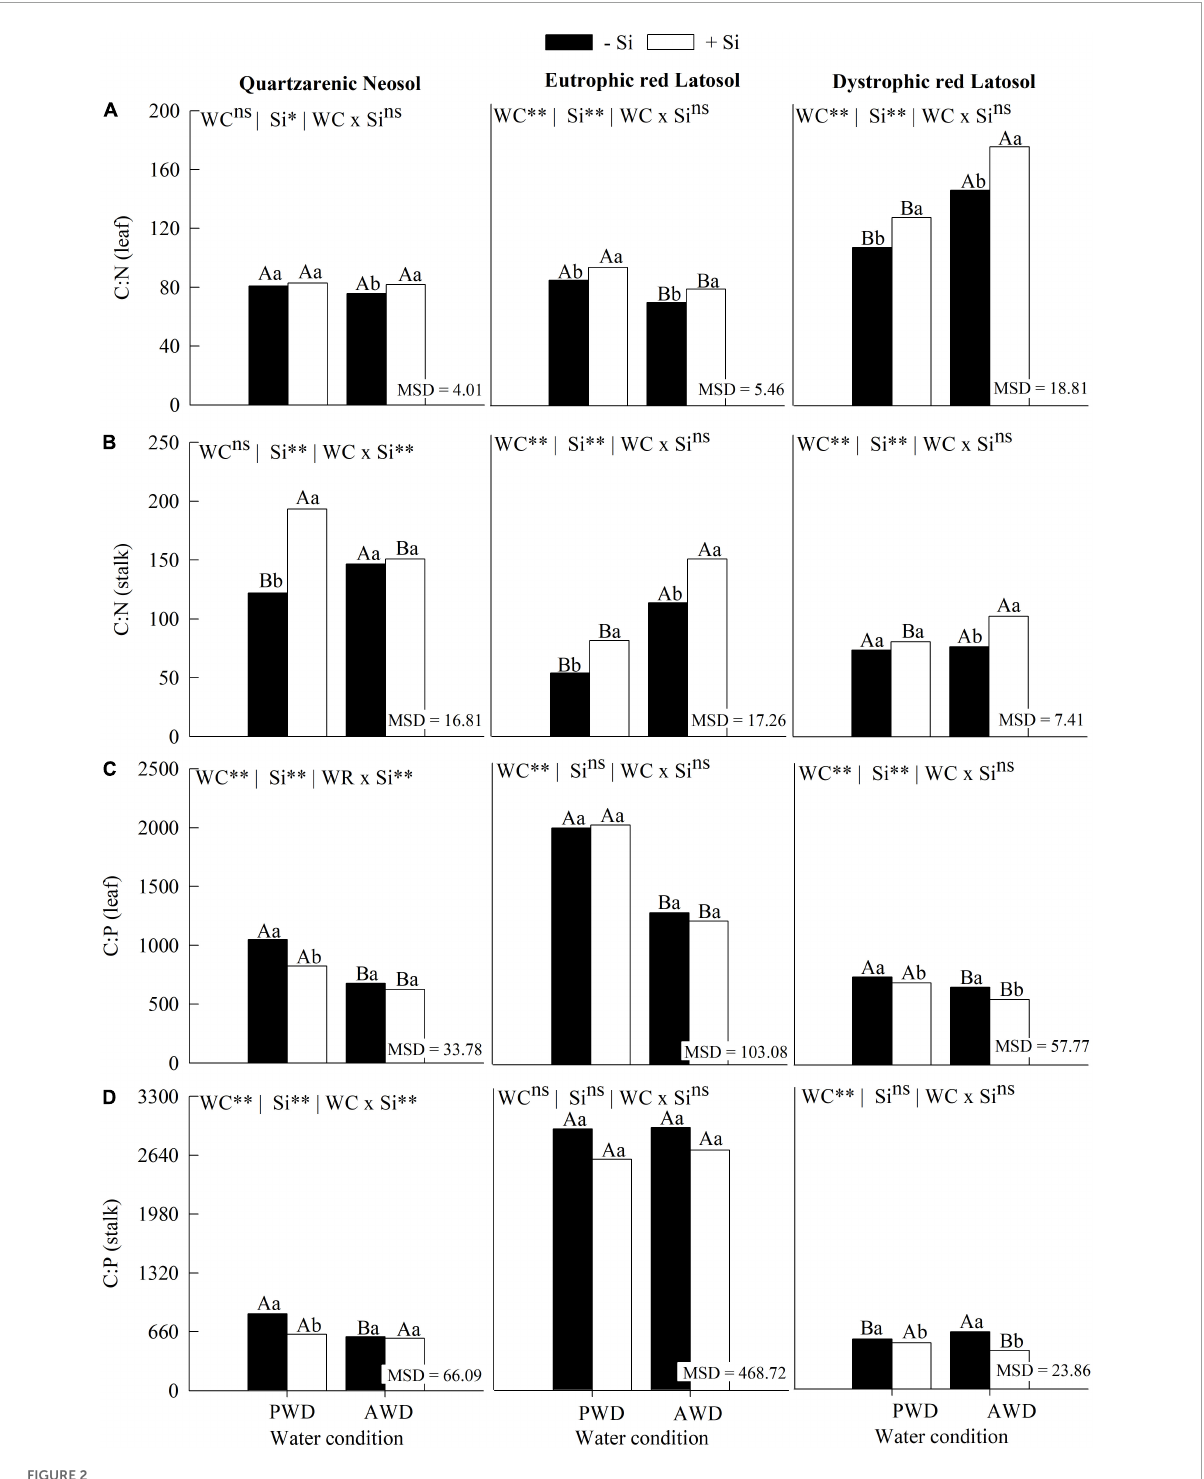
FIGURE2 Stoichiometric ratios of C:N (A,B) and C:P (C,D) in leaves and stems of sugarcane cultivated with absence (0.0 mM) and presence of fertigated Si (1.8 mM) and two water conditions (without—AWD and with water deficit—PWD) in three tropical soils (Quartzarenic Neosol; Eutroferric Red Latosol; and Dystrophic Red Latosol). WC, water condition; MSD, minimum significant difference; ** and *: significant at 1 and 5% probability, respectively; NS = not significant at 5% probability. Different uppercase letters indicate differences in water conditions and different lowercase letters indicate differences in Si fertigation by Tukey’s test ( p <